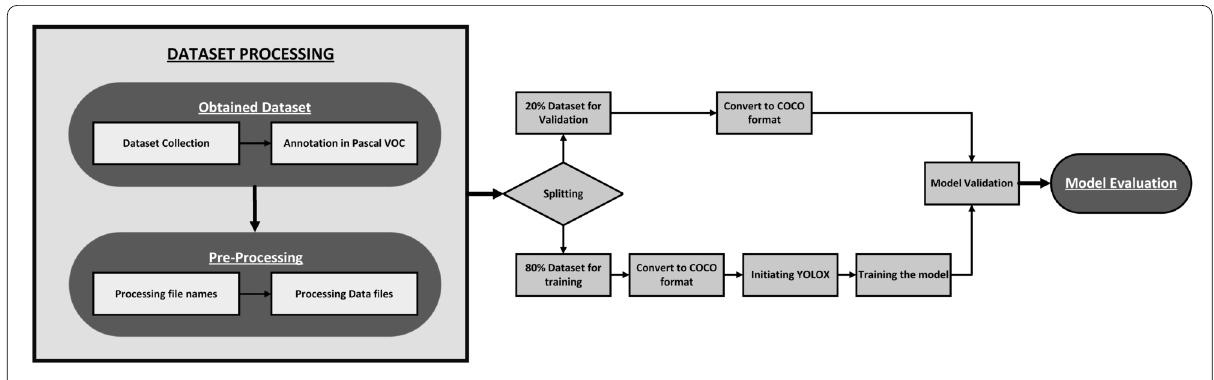
Figure 3 Flowchart of the System